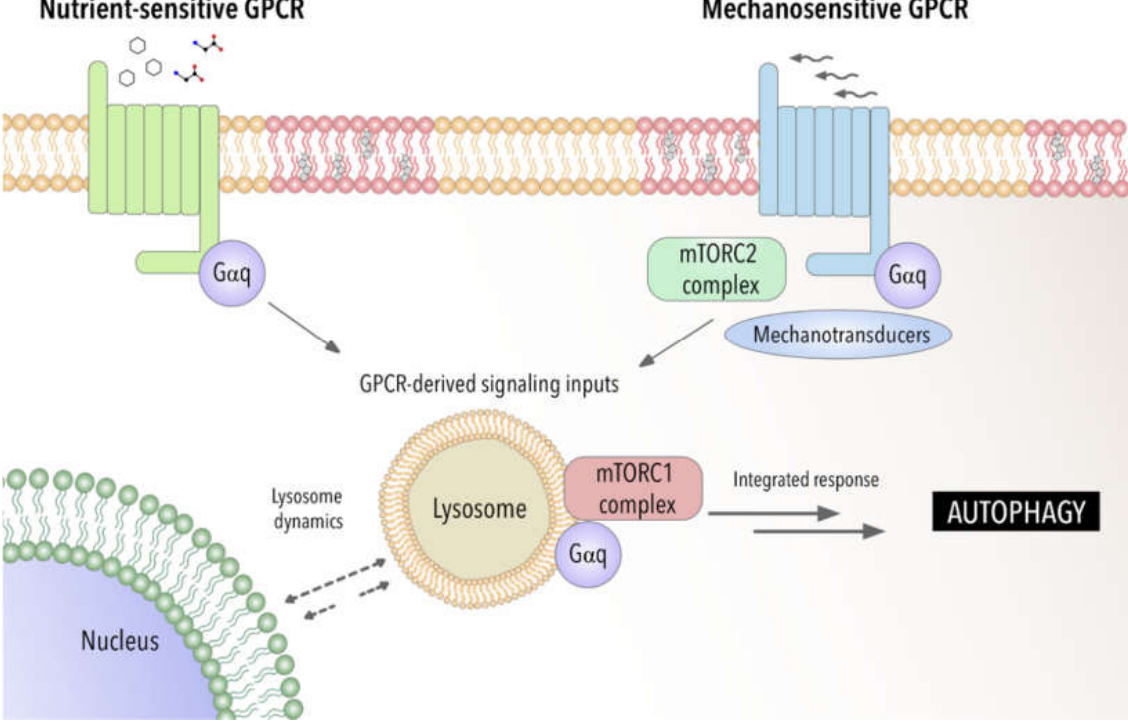
Figure 1. Gαq as a potential integrator of chemical and mechanical signals modulating autophagic process. Involvement of Gαq interactome-autophagy control in pathophysiological settings.